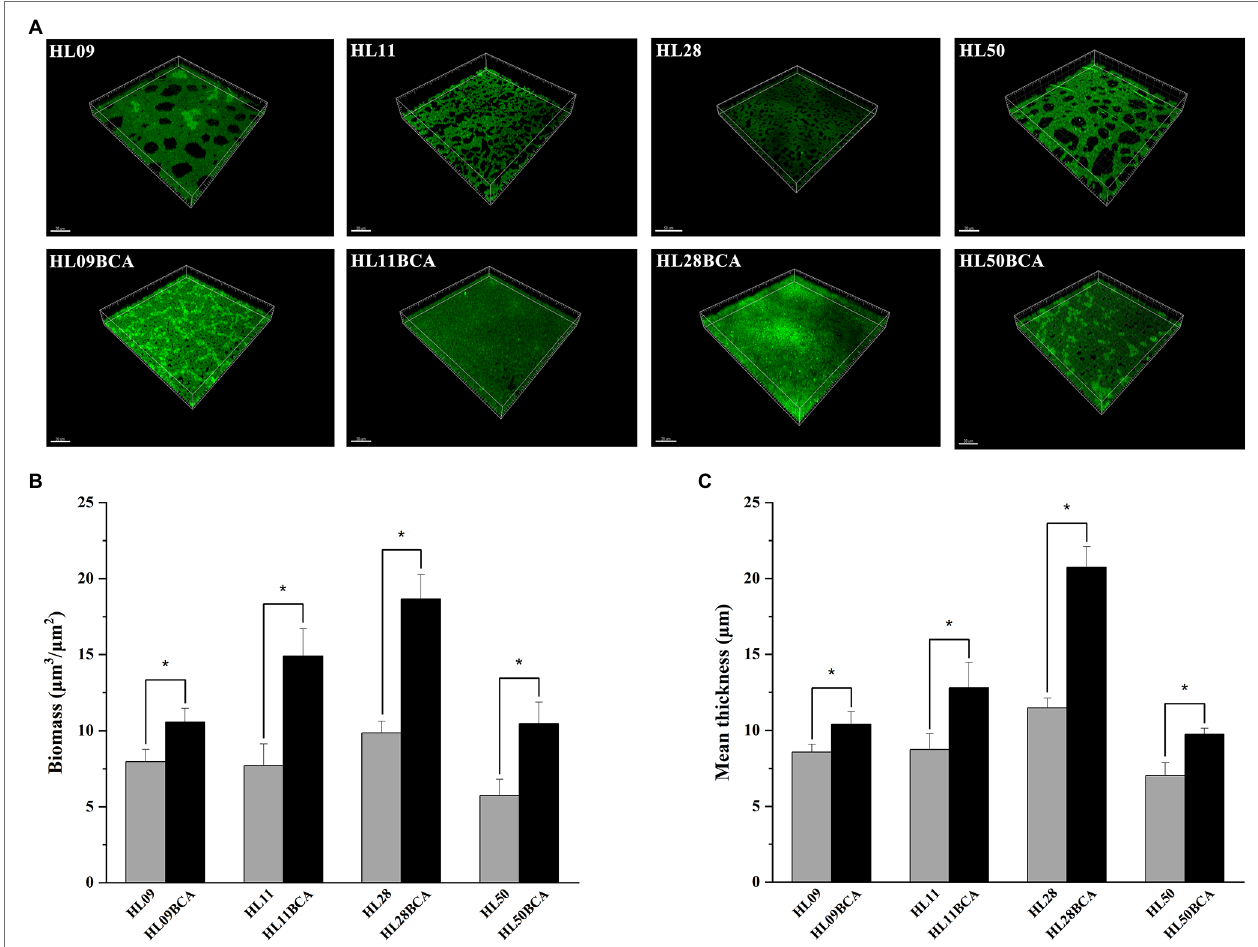
FIGURE 4 | CLSM analysis of Listeria monocytogenes biofilm. (A) CLSM images of Listeria monocytogenes strains. (B) The biofilm biomass. (C) Mean thickness of biofilm. The asterisk indicates a value statistically different from that of the wild-type strain, with p <